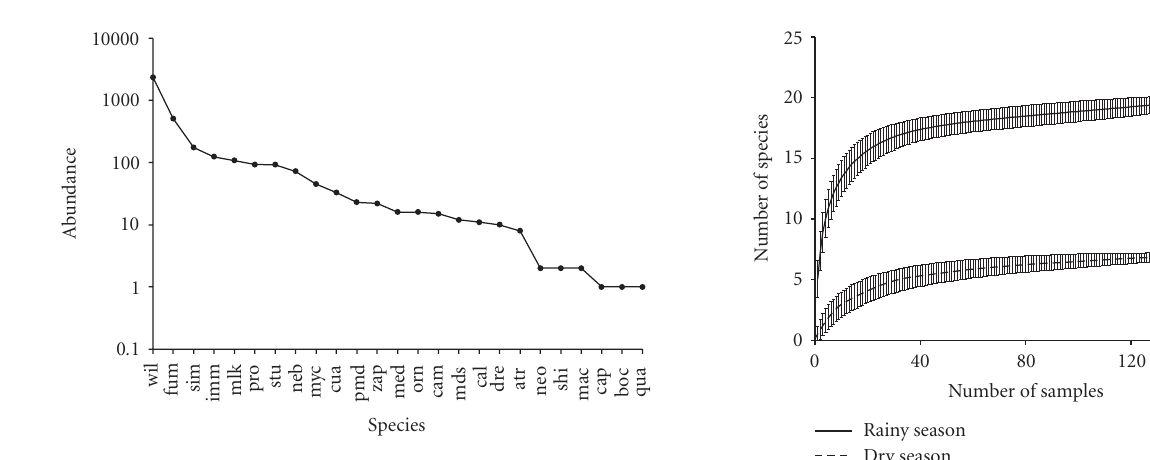
Figure 3: Density species showed by rarefaction curves (sample- based) of drosophilid species reared in Mauritia flexuosa collected in a gallery forest of the Ecological Reserve of IBGE, Bras ´ ılia, DF during the dry season (June, July and August, n = 148) and the rainy season (December, January and February, n = 160). Error bars represent standard deviation.